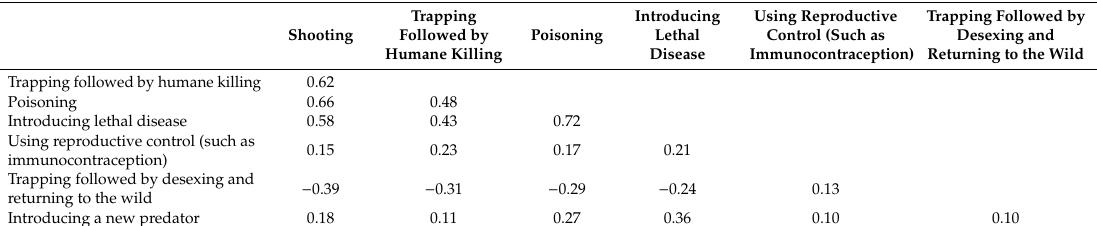
Table 4. Spearman’s correlation coe ffi cients for correlations between respondents’ views about the acceptability of various strategies for reducing or preventing wild dog and cat predation on wildlife ( n = 541 to 588 respondents for each pair-wise